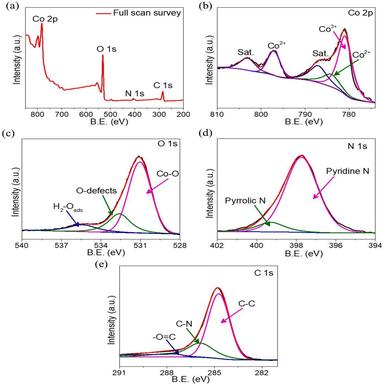
XPS spectra of (a) full survey spectrum of Co-O-NSs@CFC, (b) deconvoluted Co 2p, (c) O 1 s spectrum, (d) N 1 s spectrum, and (e) C 1 s spectrum.